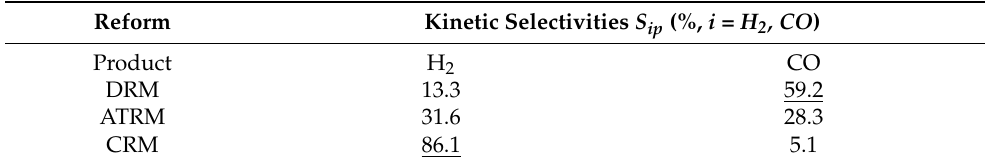
Table 9. Kinetic selectivities of products (H 2 , CO).